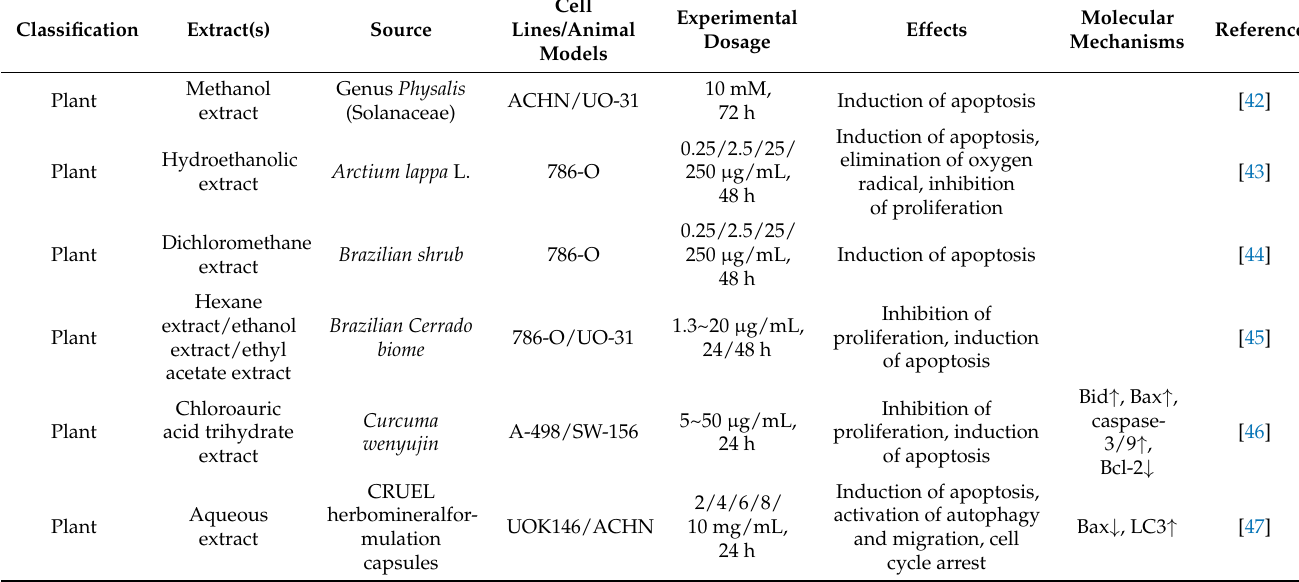
Table 2. Extracts from natural products showing cancer-intrinsic inhibition (major in apoptosis induction and/or proliferation inhibition) in renal cell